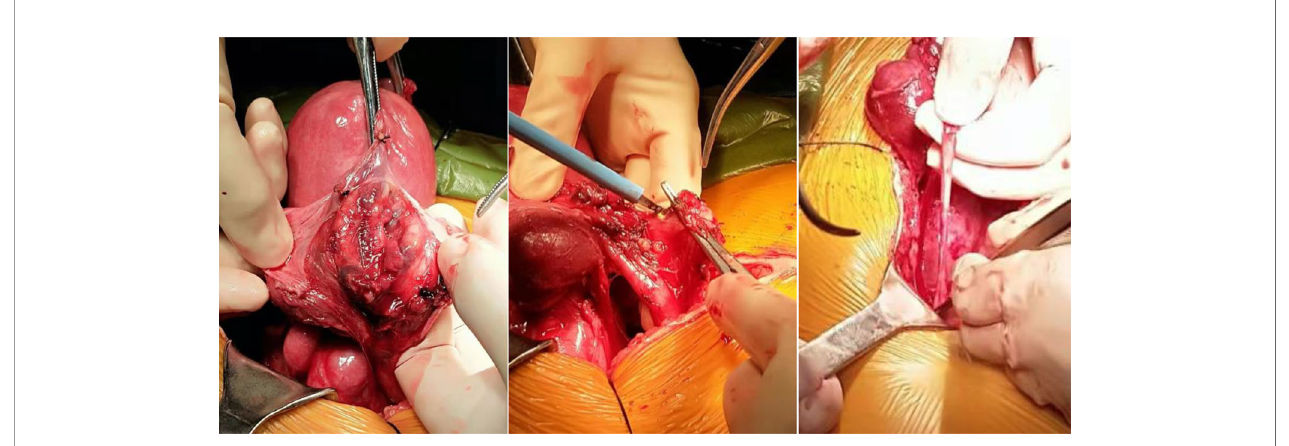
FIGURE 2 | Intraoperative fi ndings of case